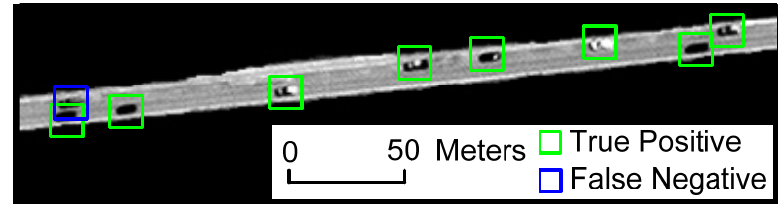
Figure 17. Moving vehicle detection results of Scene 2.